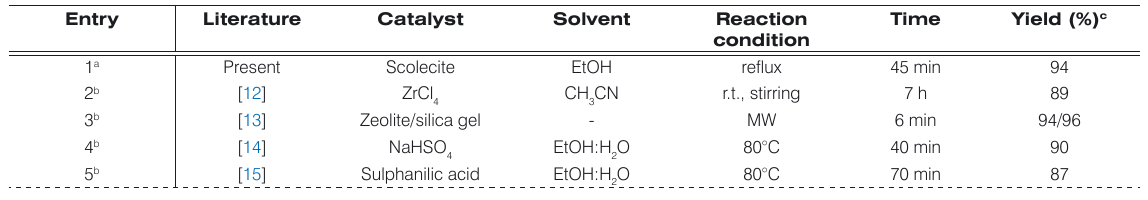
Table 3. Comparisons of some other reported procedures with the present method for the synthesis of 2-(4-nitrophenyl-4,5-diphenyl-1H-imidazole (entry 4g , Table